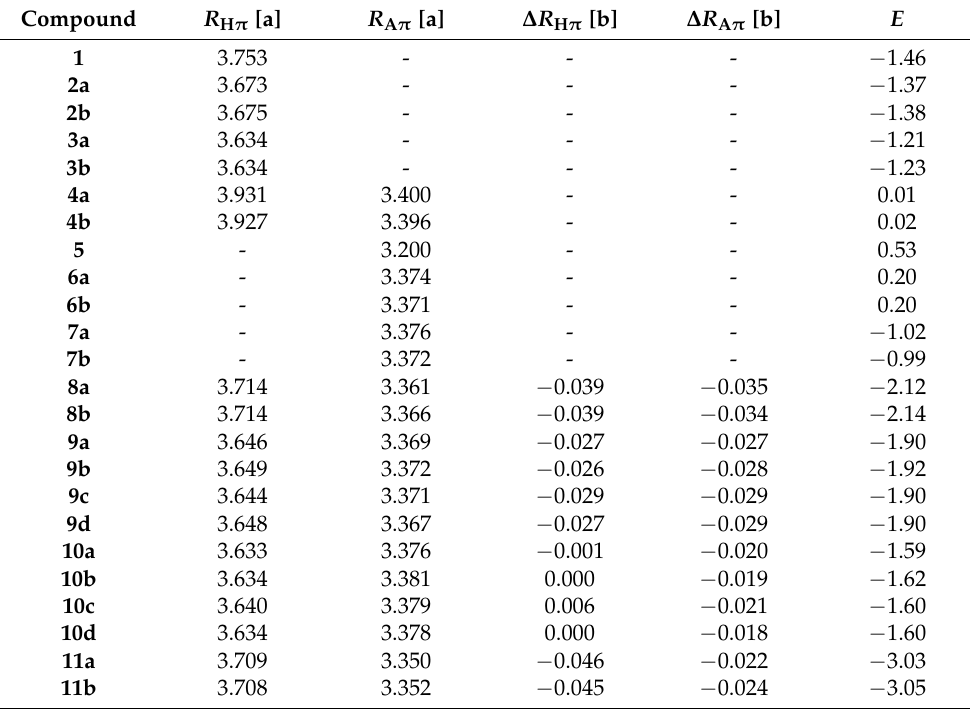
Table 1. Equilibrium distances ( R H π , R A π , in Å) at the SCS-RI-MP2/AVTZ and interaction energies ( E , in kcal/mol) at the CCSD(T)/CBS levels of theory. Compound R H π